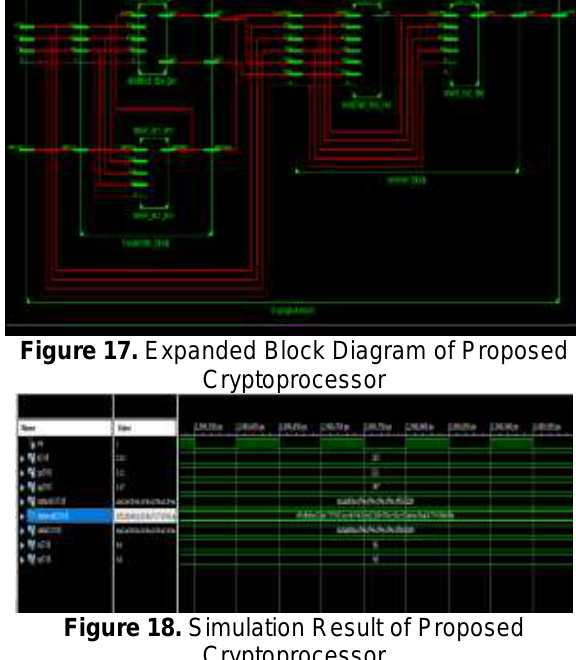
Figure 13 . Simulation Results of Cryptoprocessor Transmitter